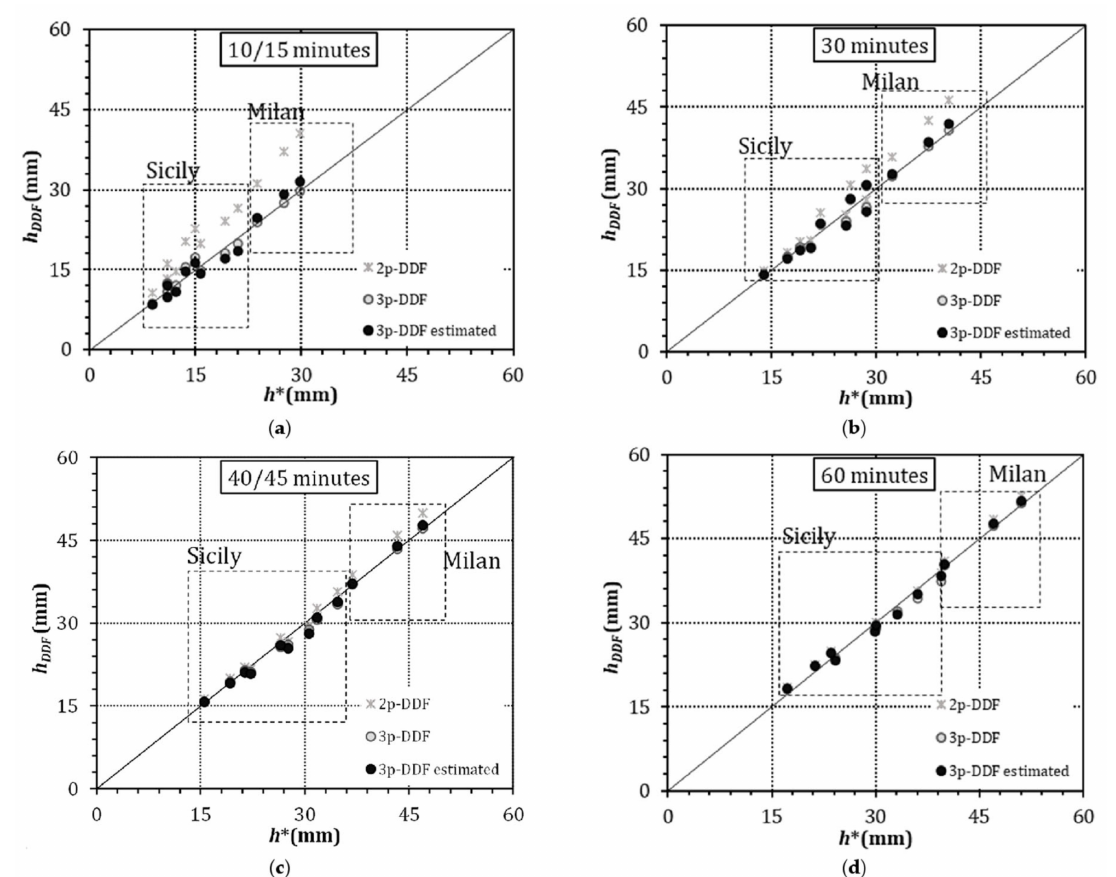
Figure 6. Comparison of rainfall depths from Gumbel distributions ( h * ) and from 2p-DDF, 3p-DDF, and 3p-DDF estimated curves ( h DDF ), for rain gauges in Sicily and Milan, with return periods of 5, 10 and 15 years and durations of ( a ) 10/15 min, ( b ) 30 min, ( c ) 40/45 min, and ( d ) 60 min.